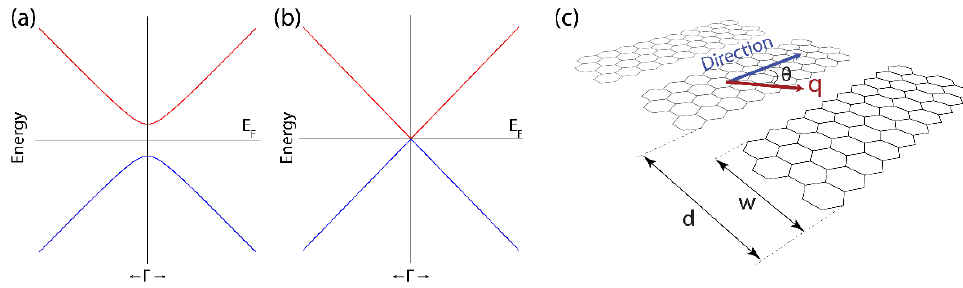
Figure 3. Typical behavior of the highest valence band (blue) and the lowest conduction band (red) of ( a ) narrow and ( b ) wide GNRs, for values of the 1D crystal momentum around the Γ point ( 𝑝 ∥ → 0 , cfr. Equation (3) with n = 1). ( c ) Schematics of a freestanding GNR array, in which each GNR is characterized by the width 𝑤 , and the lower edges of contiguous GNRs are separated by the distance 𝑑 . Accordingly, 𝑑 − 𝑤 represents the vacuum distance between contiguous GNRs.